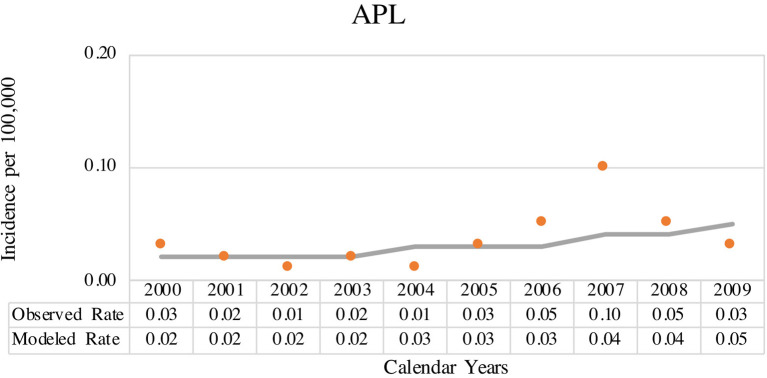
Joinpoint analysis for age-adjusted incidence rate (AAIR) (0–19 years, standard world population) from acute promyelocytic leukemia (APL) in Brazilian population-based cancer registry (PBCR), 2000–2009. Solid circles indicate the data for observed age-adjusted rate and solid line indicates the data for modeled age-adjusted rate.